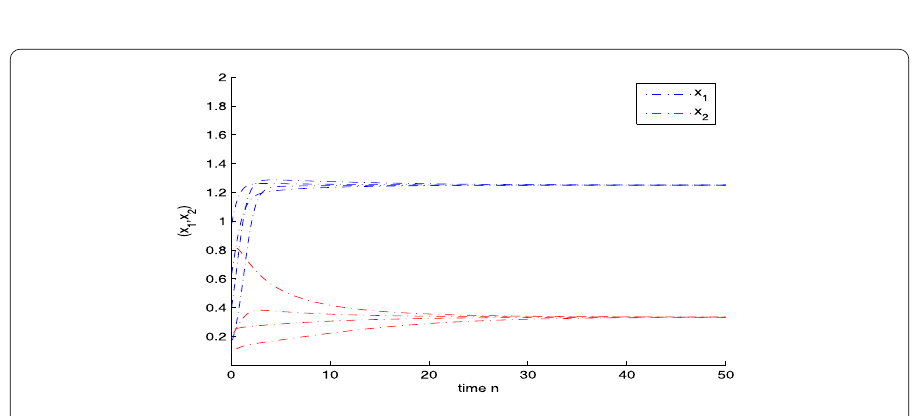
Figure 4 Numeric simulations of system (4.2) with initial conditions ( x (0), y (0)) = (0.14,0.19),(0.37,0.009),(0.95,0.024) and (0.60,0.82).